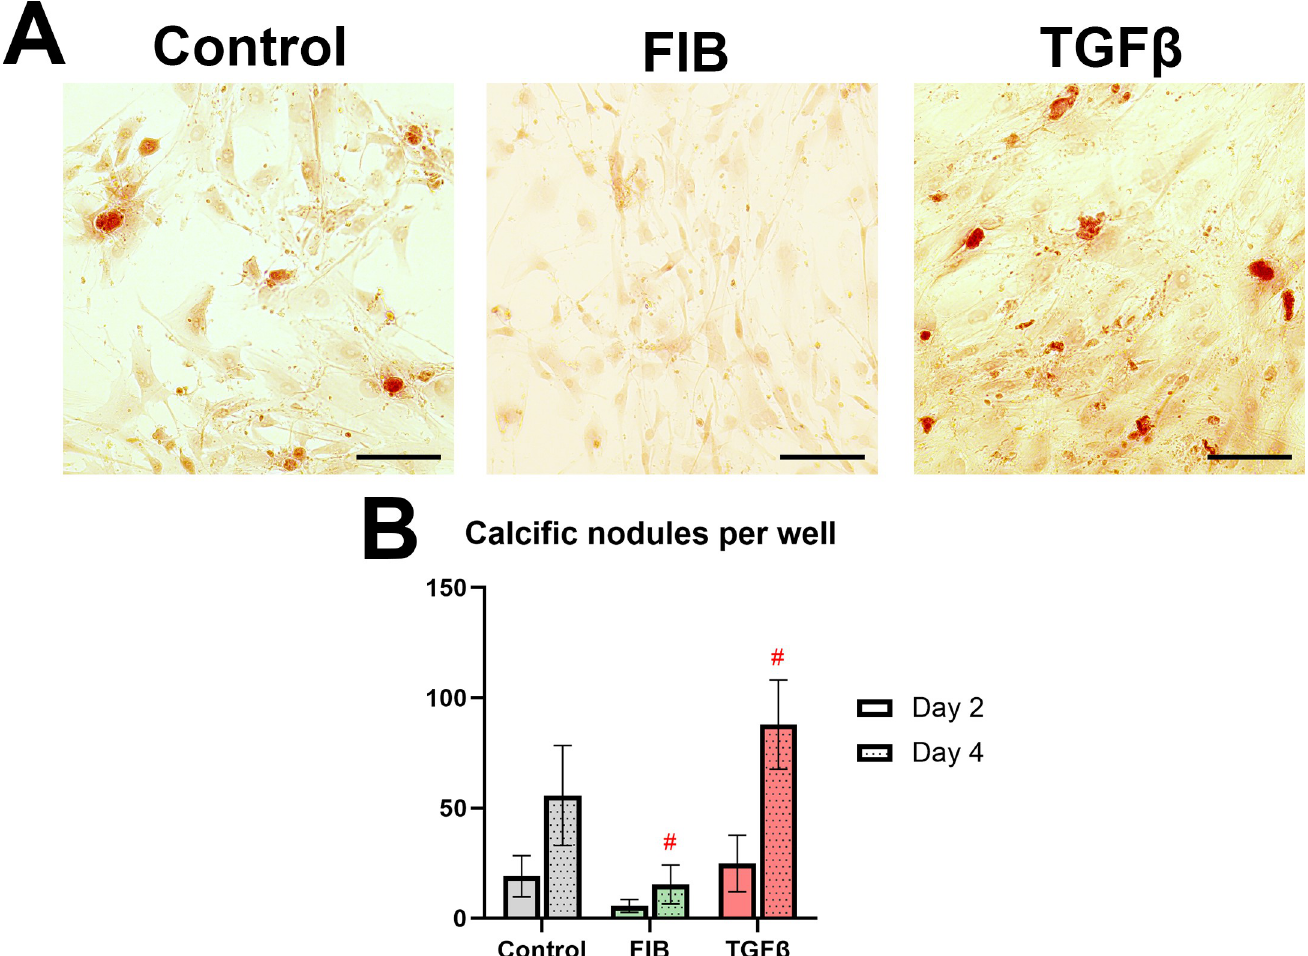
Fig 7. FGF-2 inhibits nodular calcification. (A) shows alizarin red stained hVICs on day 4. Scale bars represent 100 μ m. (B) shows the number of calcific nodules per well on day 2 and day 4, counted manually from n = 4 biological repeats, with 2 wells per group. A 2-way ANOVA compared the experimental groups with control at each time point. � p < 0.05, #p < 0.01, error bars represent 95%